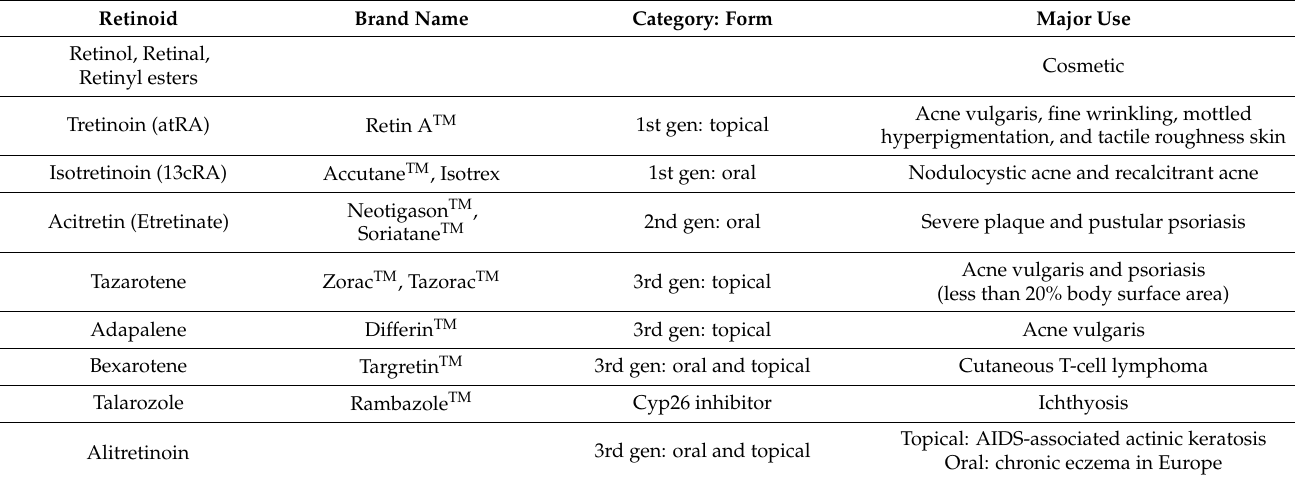
Table 2. Clinical uses of retinoids